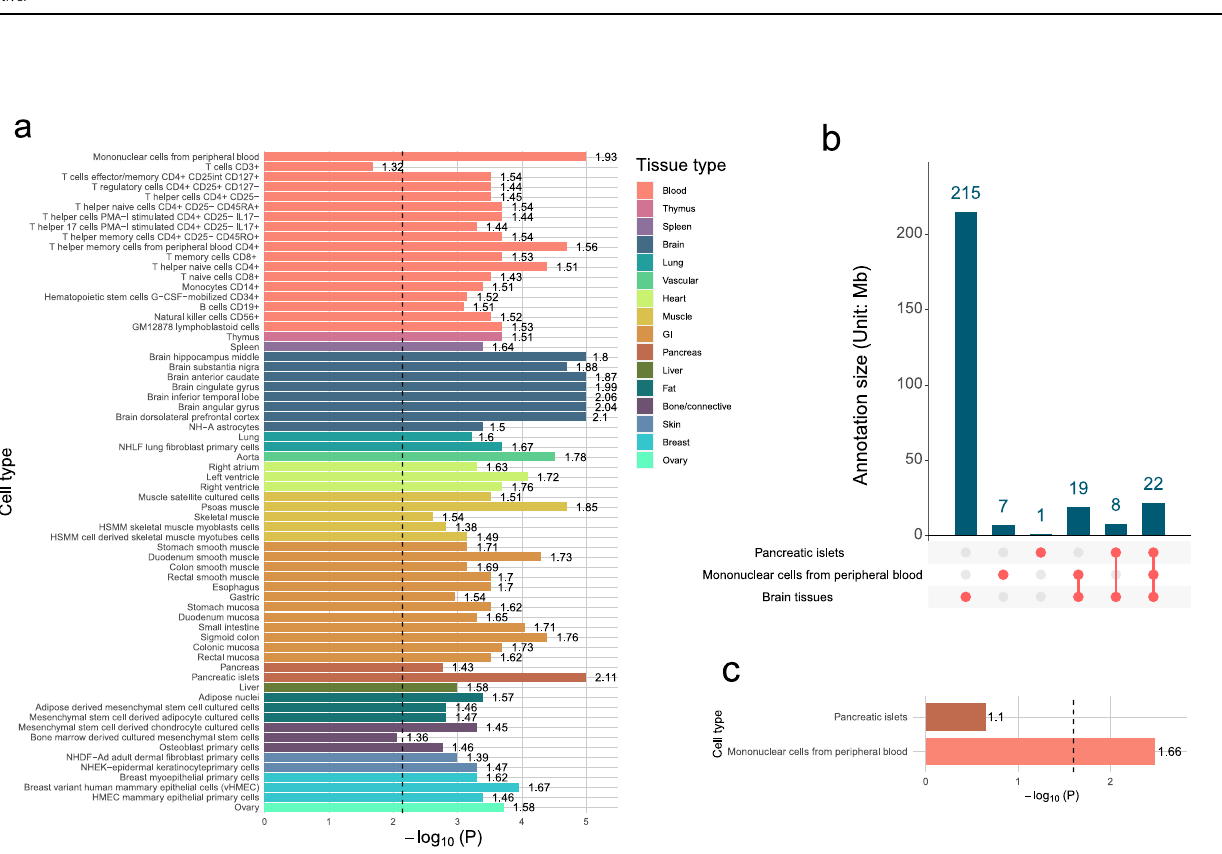
Fig. 5 Tissue-speci fi c enrichment of genome regions conferring risk for multiple neuropsychiatric traits. a Permutation test results over 66 cell-type- speci fi c annotations. Fold enrichment is labeled next to each bar. b The overlap of predicted functional regions in pancreatic islets, mononuclear cells from peripheral blood, and eight brain regions. c Enrichment in the predicted functional regions in pancreatic islets and mononuclear cells from peripheral blood after conditioning on the annotation overlap with brain